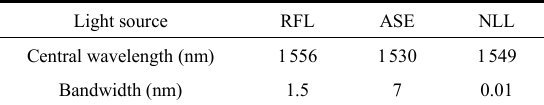
Table 1 Optics spectrum.